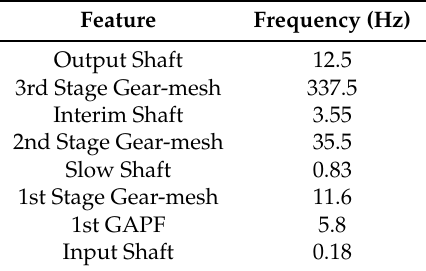
Table 2. The characteristic frequencies of the used gearbox at 740 rpm speed. Here the GAPF stands for Gear Assembly Phase Frequency.